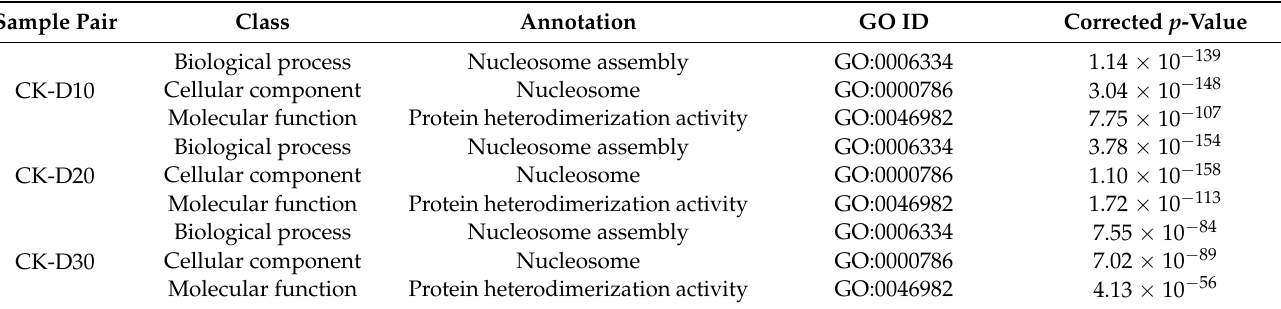
Table 1. The main GO enrichment of the DEGs at different